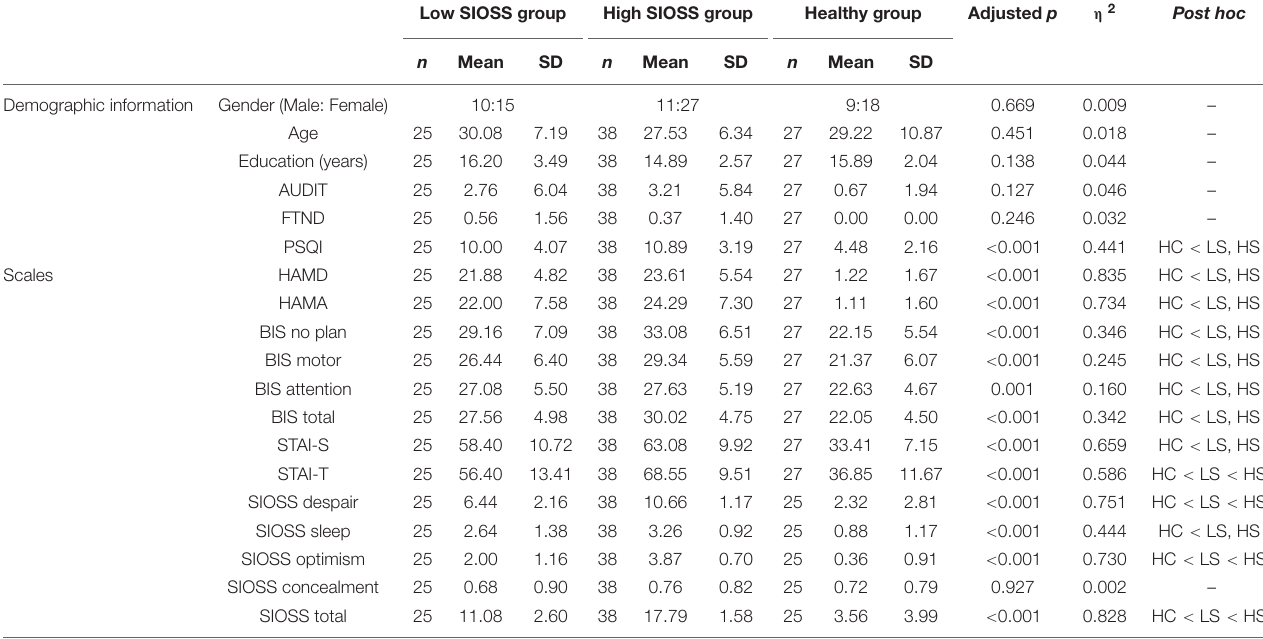
TABLE 1 | Demographic and clinical characteristics of patients with low suicidal ideation, patients with high suicidal ideation, and healthy subjects. Low SIOSS group High SIOSS group Healthy group Adjusted